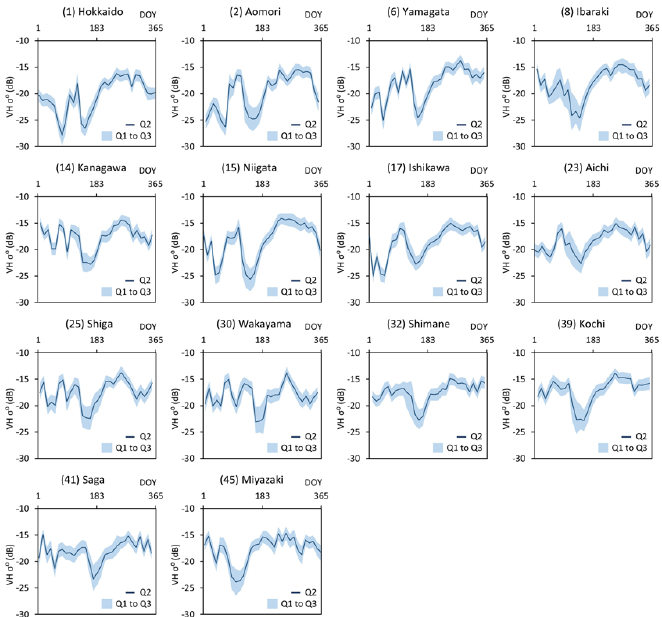
Figure 5. Time series variation of Sentinel-1 VH σ 0 in 2018 for each “Paddy” reference field region. The first (Q1), second (Q2), and third (Q3) quartiles of VH σ 0 over “Paddy” reference fields were calculated for all pixels included within “Paddy” reference fields, with a 10 m spatial resolution. Blue lines indicate the Q2 values, and blue shading indicates the Q1 to Q3 interval.